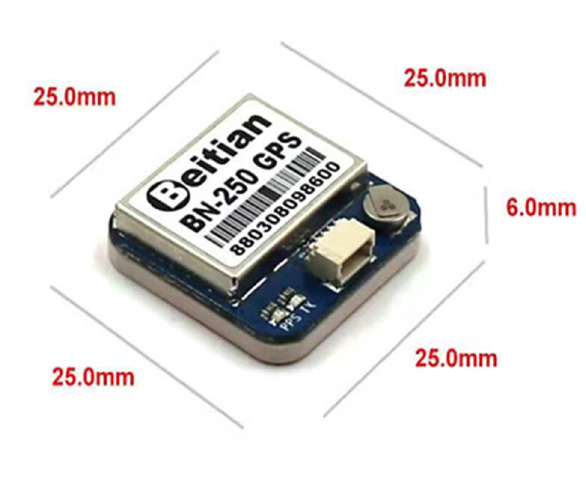
Figure 3. BN-250 positioning + antenna integrated module.